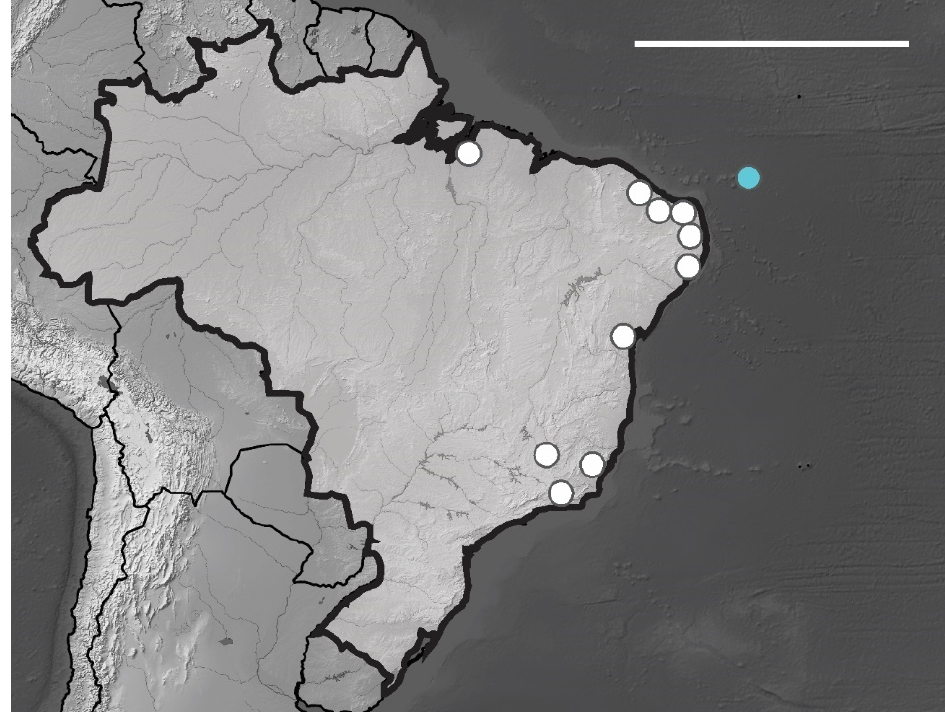
Figure 13. Distribution map for Brachystomella agrosa Wray, 1953 recorded in Brazil. Blue circle, Fernando de Noronha; white circles, Brazilian states. Scale bar: 3000 km. Biogeographic Distribution . The type locality of this species is Maricao, Puerto Rico, col- Identification Key for the Species of Brachystomella Ågren, 1903 Recorded in Brazil lected by M. Capriles, take on Road 27, at 120 m altitude. According to [1], this species has been found in the following biogeographic regions: Caribbean mainland (24a), Antillean and South Florida (24b), Venezuela and Guiana (25), Amazon (26), Northeast and Central Brazil (27). Neotropical species. the description morphological of this taxon, such as: [18–21]. The specimens of B. agrosa examined agree with the above descriptions. For comparisons between Brachystomella species recorded in Brazil, see Table